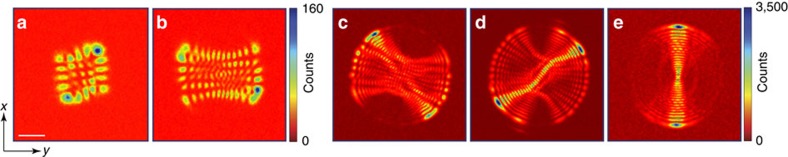
Gallery of supermode-DW-polariton condensates.(a–e) Photonic components of various high-order supermode-DW-polariton condensates. Emission clipped at large radius by limited aperture of camera imaging optics at this magnification. The colourbar for cavity emission in a–e is to the right of b,e. For all a–e, the axes and scale are indicated with the labeled arrows and the white bar as in a, where the bar equals twice TEM00 the optical waist 2w0=70 μm at the BEC.